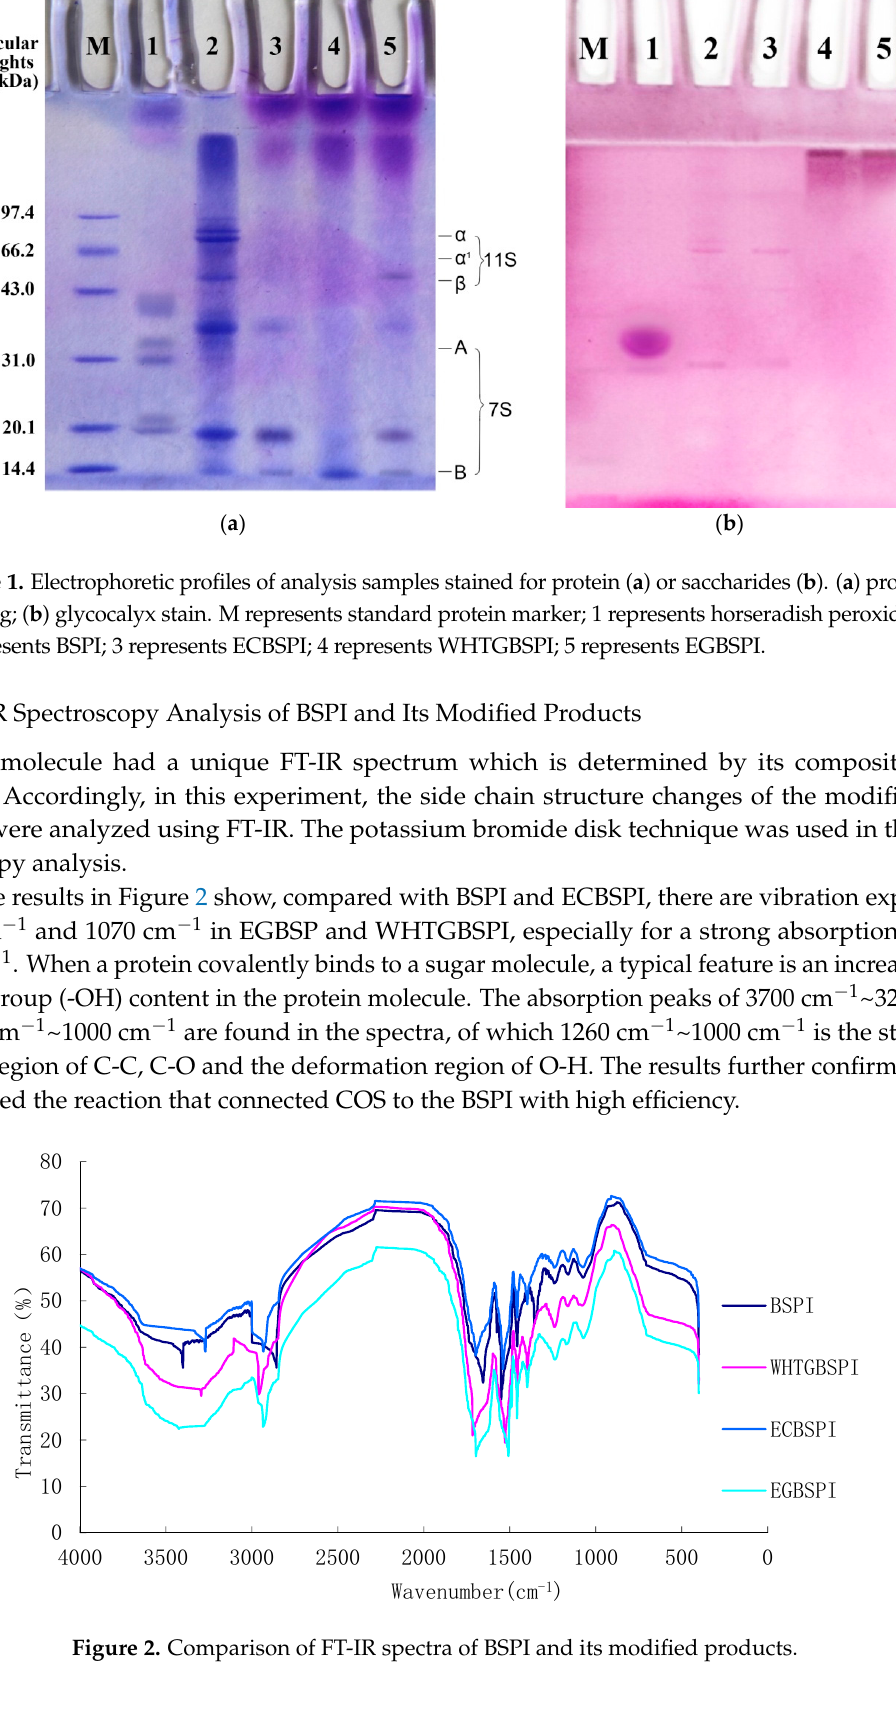
Figure 2. Comparison of FT-IR spectra of BSPI and its modified products.